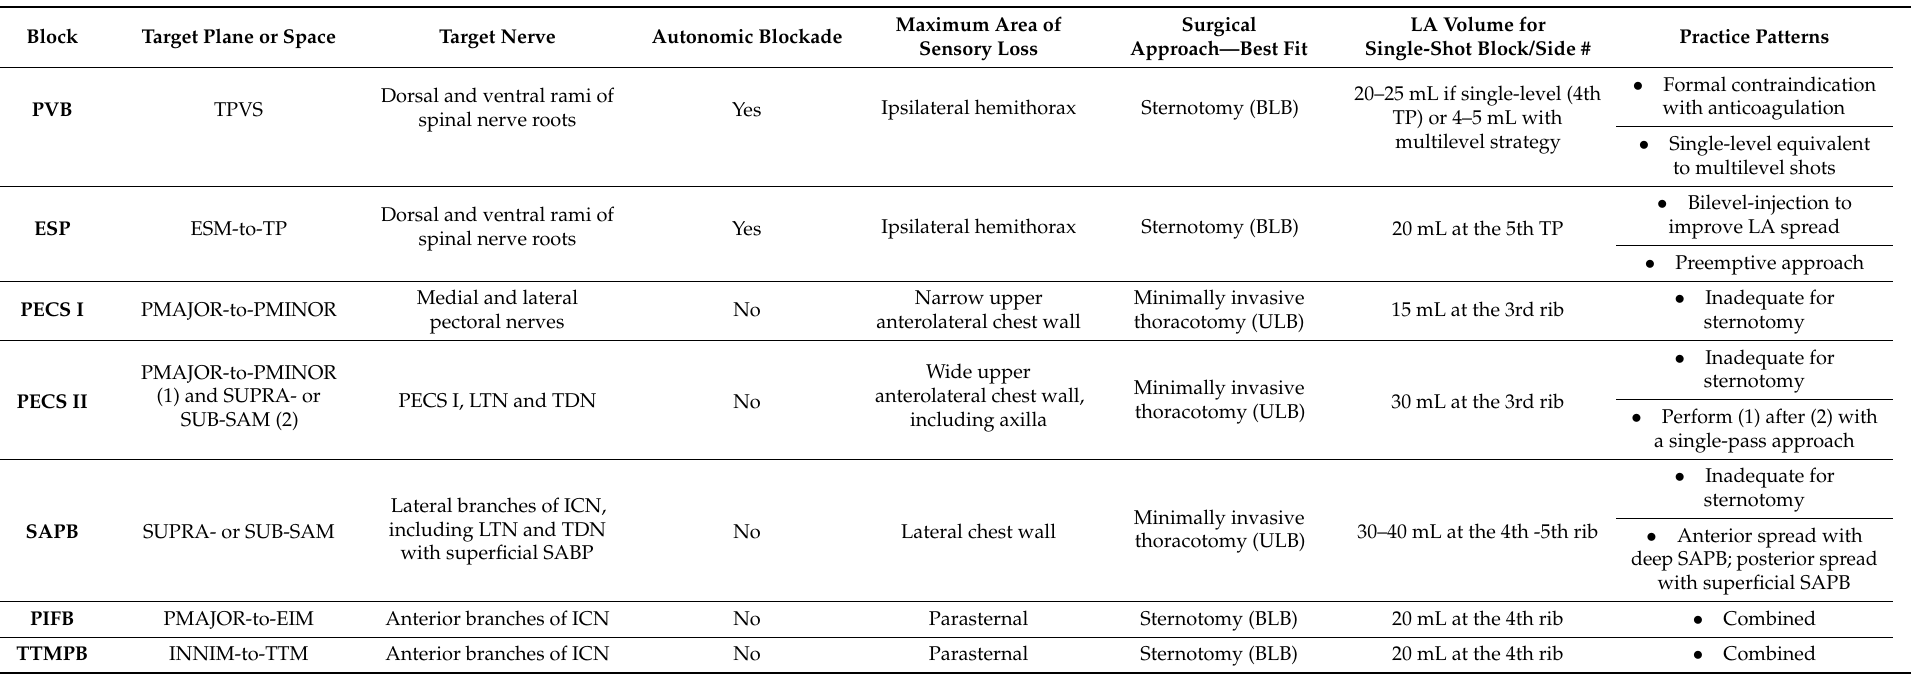
Table A1. Ultrasound-guided regional nerve blocks in cardiac surgery—technical